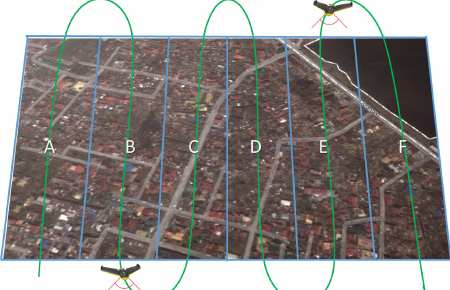
Figure 6. Example of a possible mapping area division for fixed wing